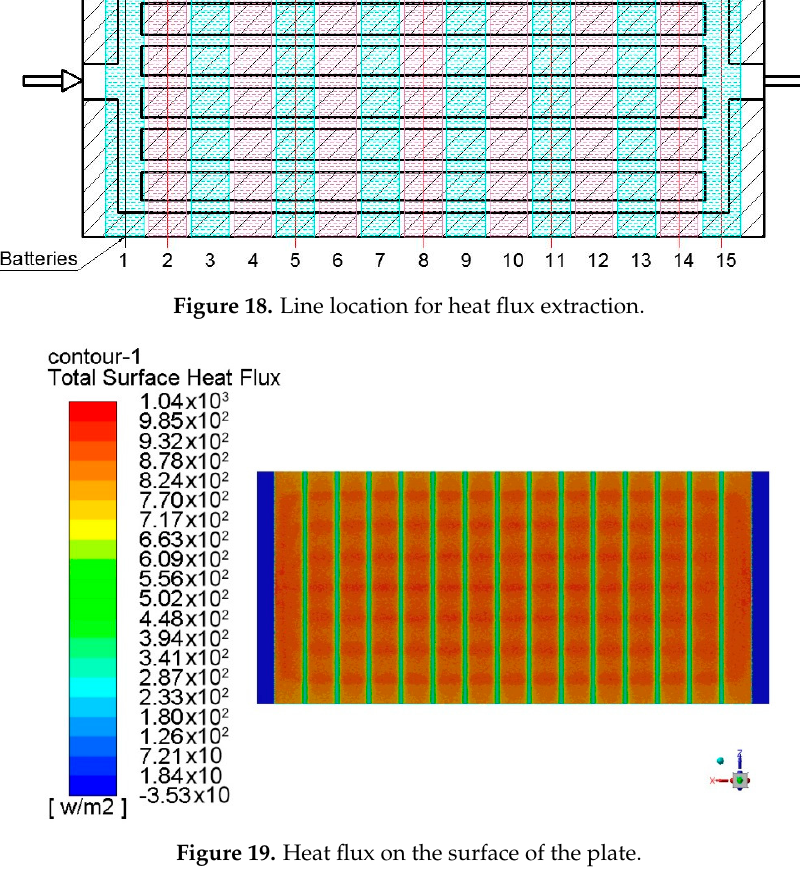
Figure 19. Heat flux on the surface of the plate.